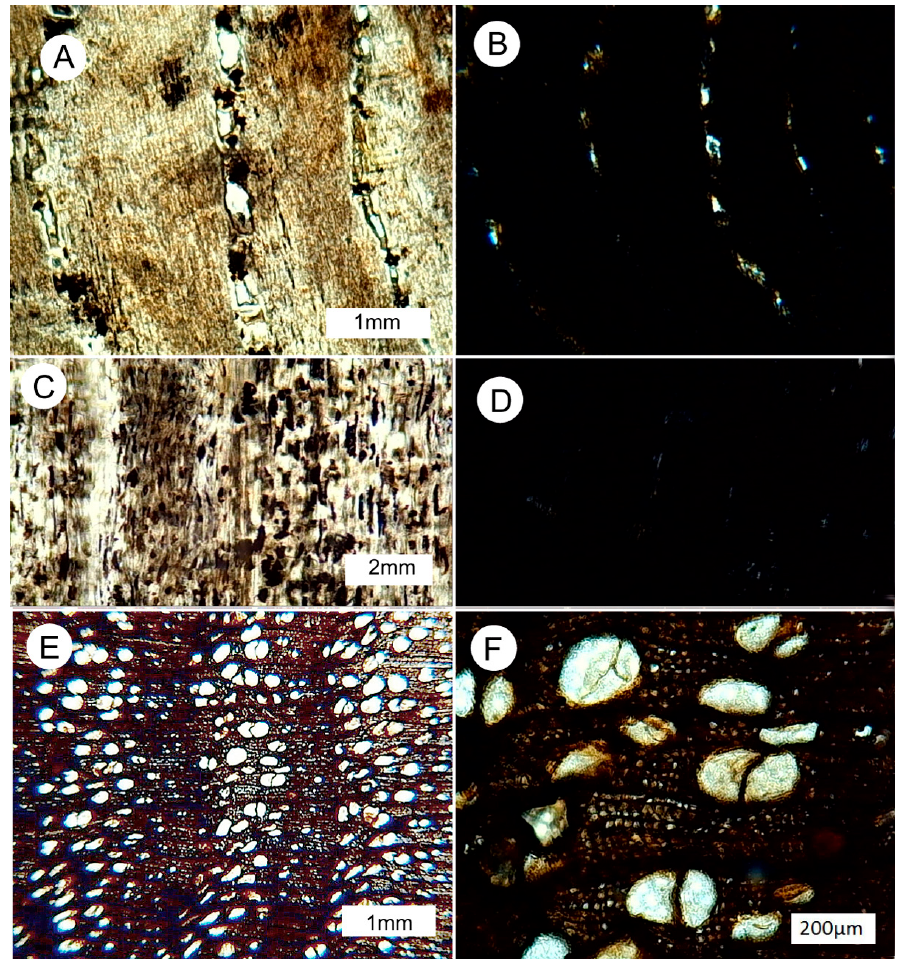
Figure 11. Optical photomicrographs of specimens that contain opal-A as the primary constituent. For photo pairs ( A , B ) and ( C , D ), the photo on the left is an illuminated with ordinary transmitted light and the right photo shows transmitted light with crossed polarizers. ( A , B ): Specimen T-2 (trunk 2), transverse view showing opal-A with small amounts of birefringent quartz filling voids. ( C , D ): T-3 (trunk 3), longitudinal view, showing isotropic opal-A as the only visible component. ( E , F ): Specimen T-19, showing transverse views under ordinary illumination. Image ( E ) shows three pairs of latewood / earlywood annual rings, and abundant vessels that are evidence that the wood is an angiosperm. At higher magnification, image ( F ) shows that some vessels are partitioned by tyloses, which are present in heartwood rather than sapwood. This feature is consistent with the position of this sample in the fossil trunk (e.g., it was collected from a middle position rather than the outer zone). Under polarized light, specimen T-19 is isotropic, producing a black field of view similar to photo ( D